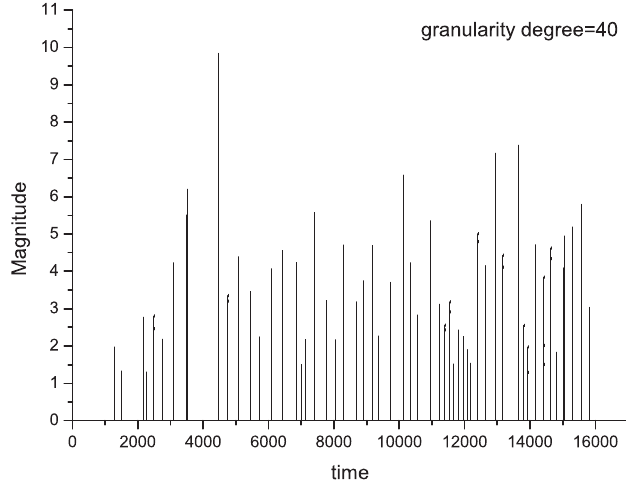
Figure 3. Example of synthetic seismicity obtained during one run.